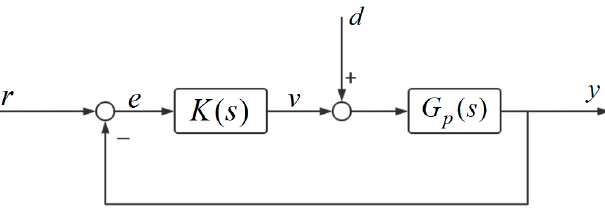
F . Figure 6. 1DOF PID control system F 2 .